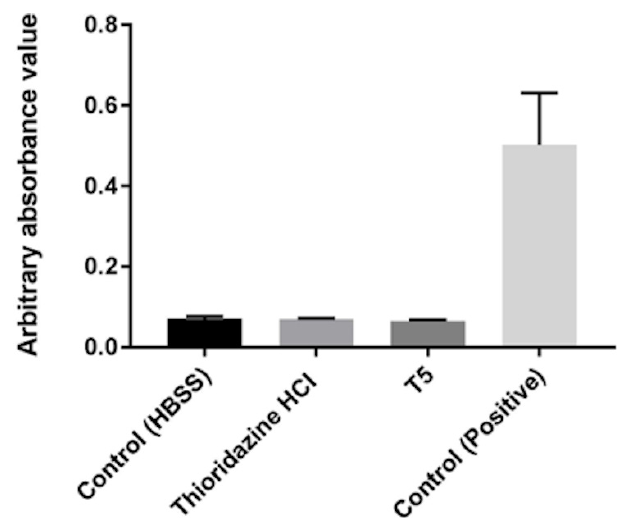
Figure 2. Lactate dehydrogenase (LDH)-based cytotoxicity assay. The figure shows absorbance (at 492 nm) on the y -axis as a measure for the lactate dehydrogenase (LDH) release from IPEC-J2 MDR1 cells exposed to thioridazine HCl and T5. Hank’s balanced salt solution (HBSS) was used as negative control, and cell lysate from IPEC-J2 MDR1 cell monolayers treated with ultrapure water was used as a positive control. The error bars indicate standard deviations of the mean values.